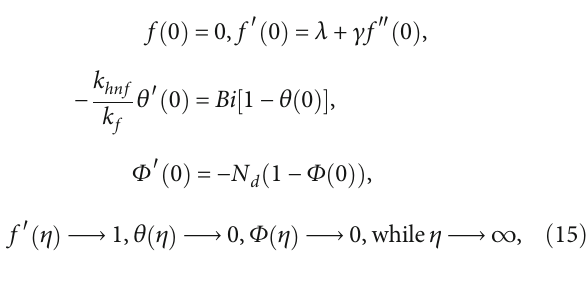
O and H O 2 3 2